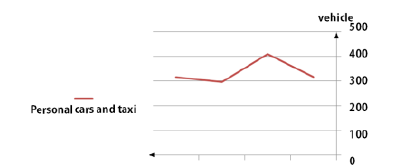
Figure. 4 Bar chart obtained from (one hour) field measurements of the number of passing vehicles at 7:00 in the morning, June 2, 2012